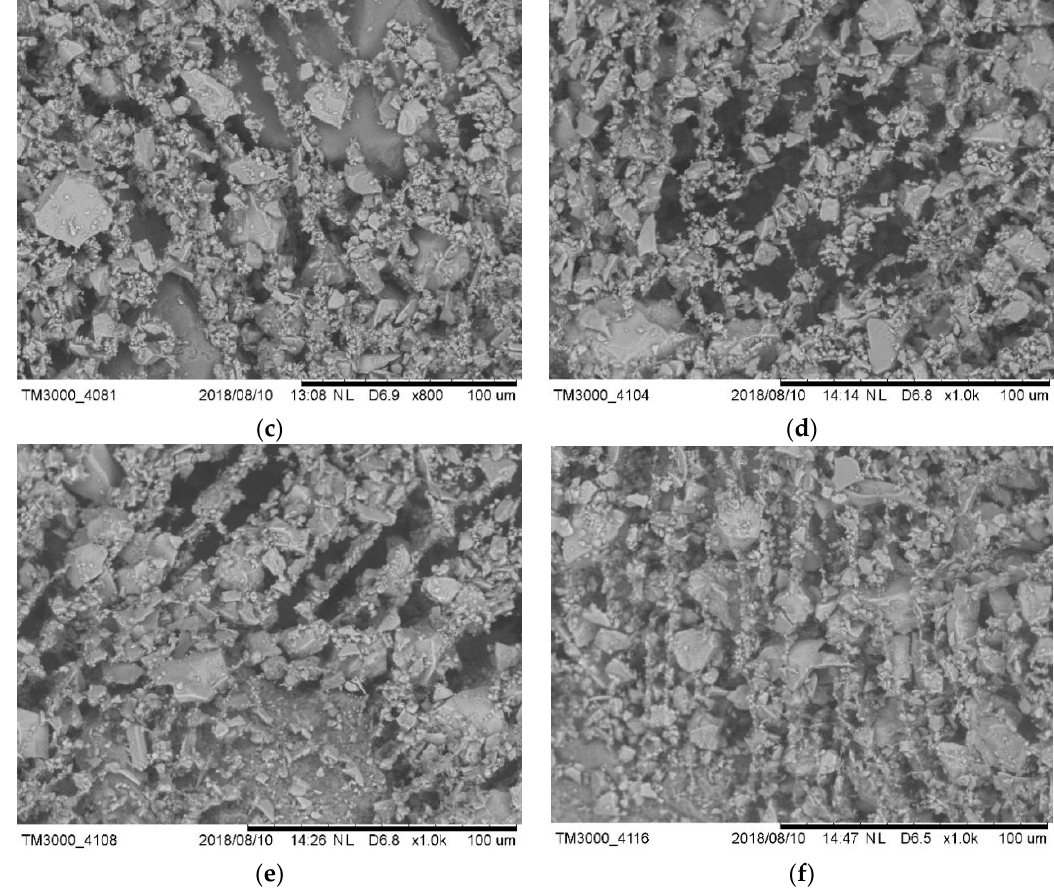
Figure 12. SEM image of freshly mixed plastic cement mortar: ( a ) control; ( b ) 0.01%; ( c ) 0.05%; ( d ) 0.1%; ( e ) 0.3%; ( f ) 0.5%.